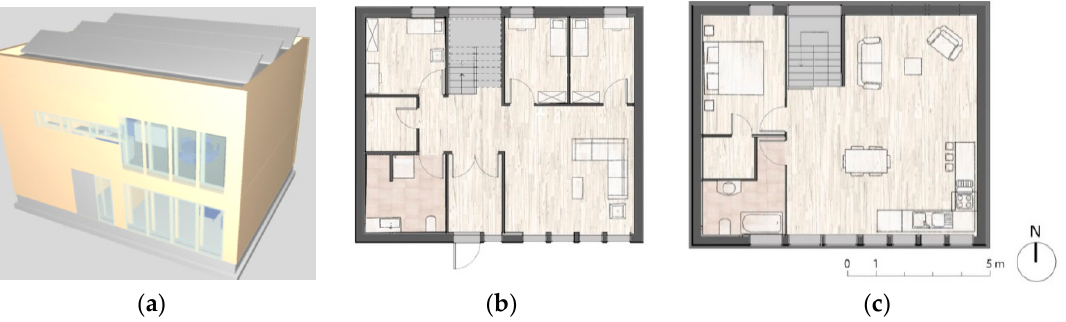
Figure 2. View of the zero-emission building (ZEB) Base Case ( a ), plans of the ground floor ( b ), and the first floor ( c ).